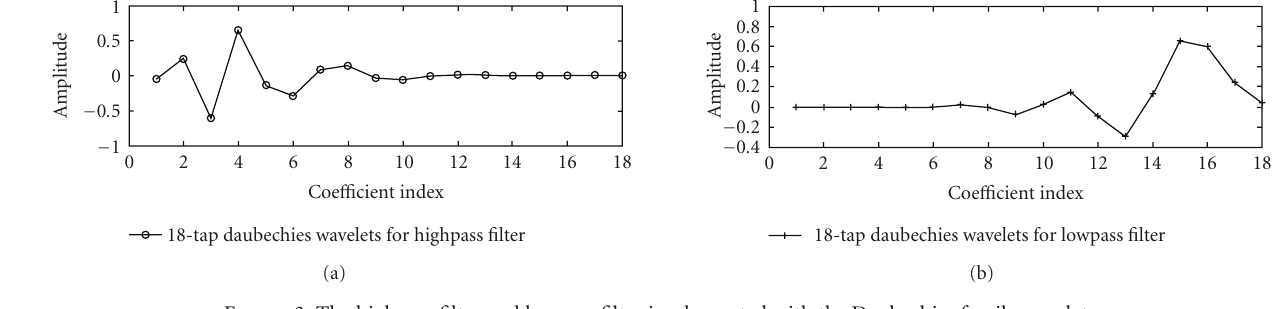
Figure 3: The highpass filter and lowpass filter implemented with the Daubechies family wavelet. where w j ( k ) means the k th coe ffi cient of the ξ th subband on ξ level j . PWPT {·} denotes a process of